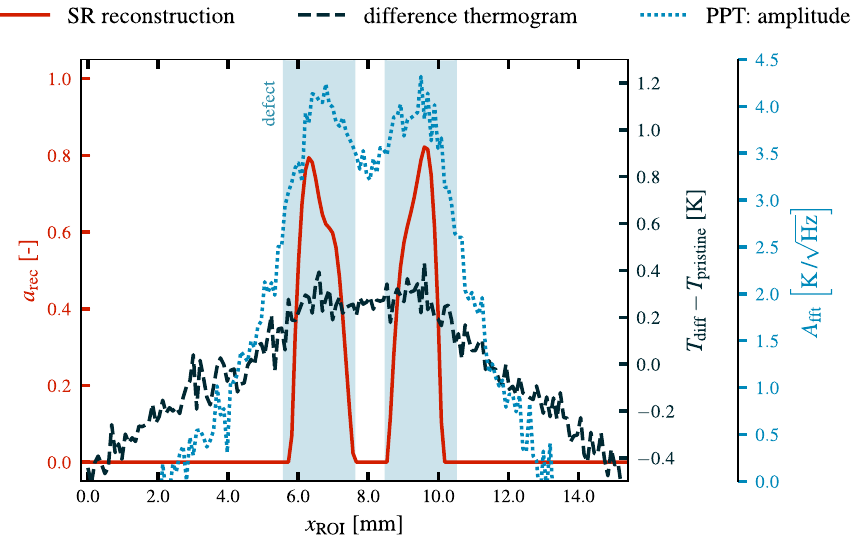
Figure 9. Sectional view of the comparison of the results of different defect detection methods over a defect pair at y ROI = 2.81 mm . Here, the (sparse) photothermal SR reconstruction result as obtained in Fig. 7 is shown in conjunction with the results from the difference thermogram and the amplitude of the PPT